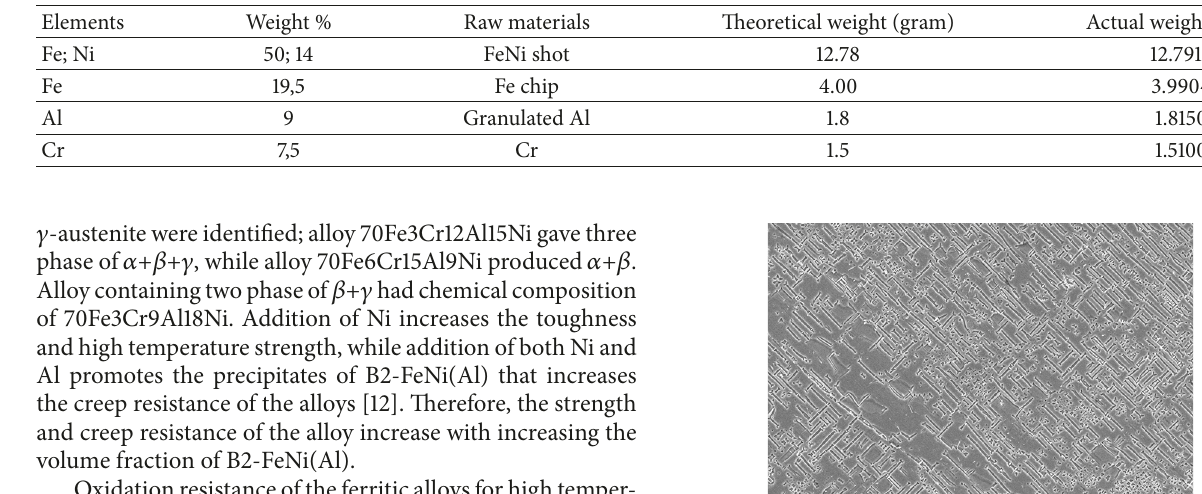
Table 1: Raw material proportion for alloy making.